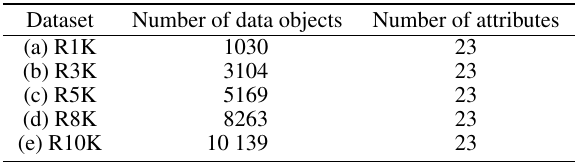
Table 2 Different sizes of real-world dataset.